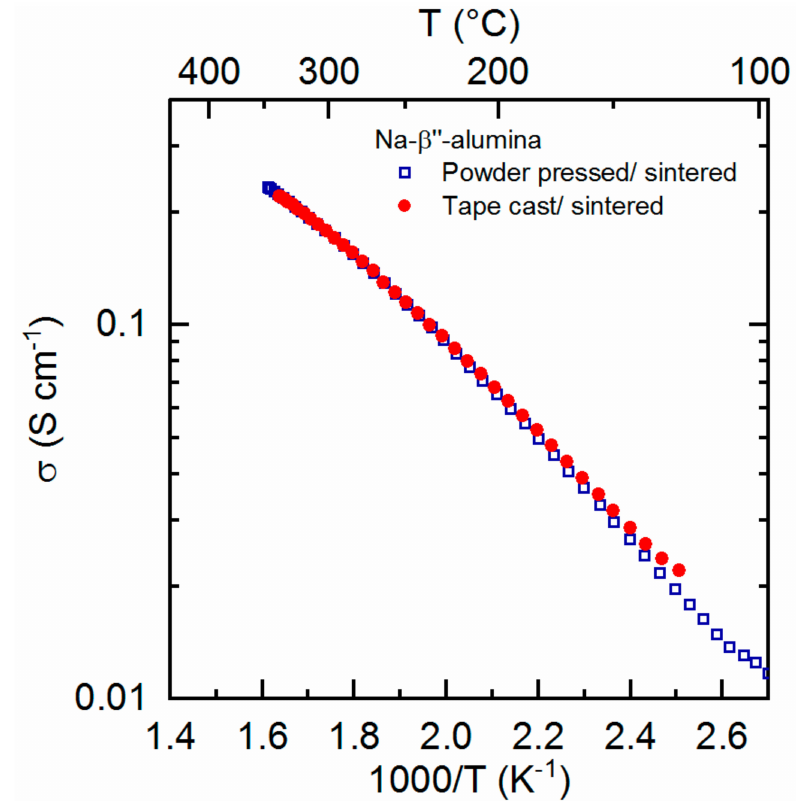
Figure 4. Na + conductivity of Na- β ”-Al 2 O 3 ceramics prepared by uniaxial powder pressing and sintering (blue squares) vs. Na- β ”-Al 2 O 3 ceramics prepared by tape casting and sintering (red